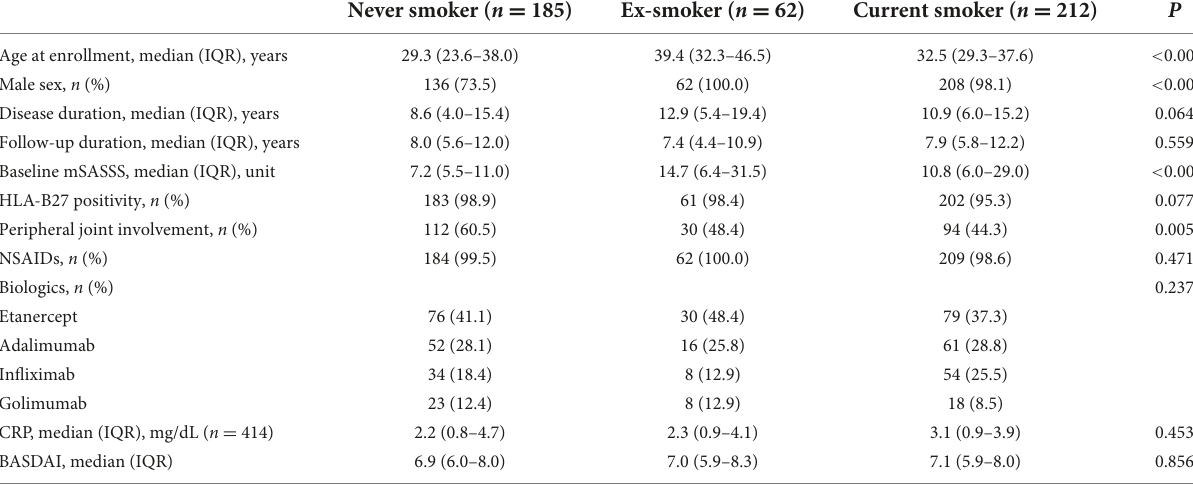
TABLE 2 Differences of characteristics of patients according to baseline smoking status.